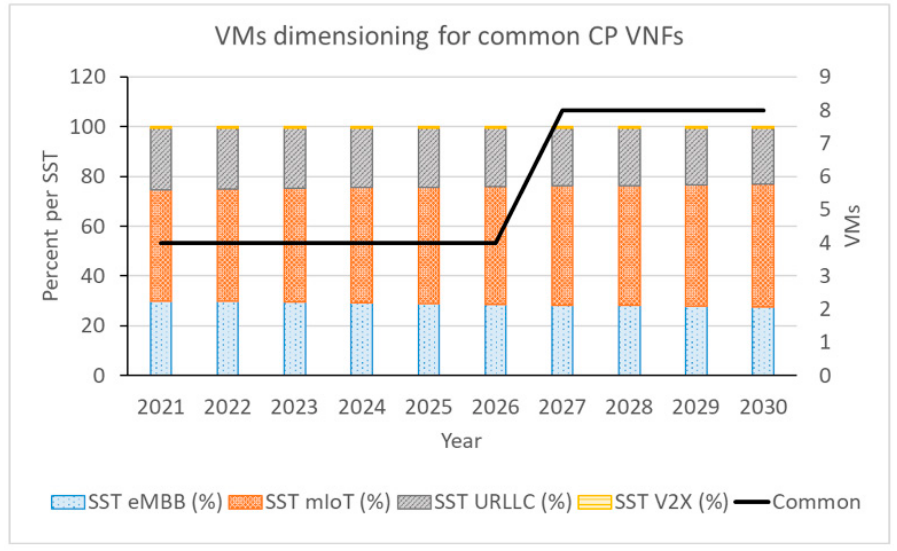
Figure 7. VMs dimensioning for common CP VNFs.